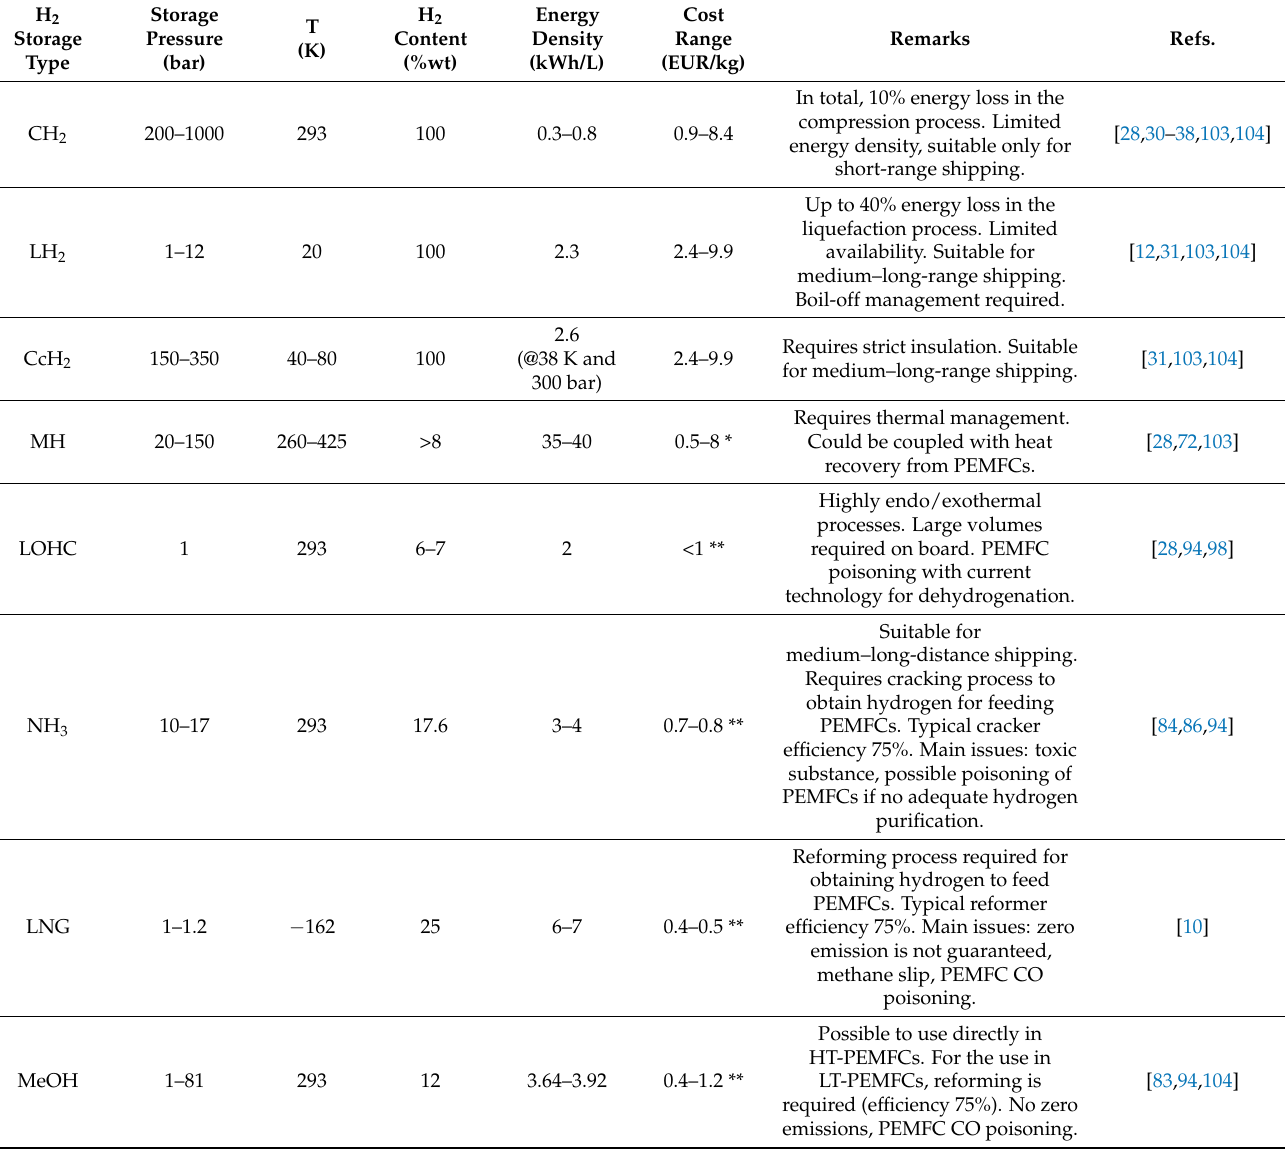
Table 2. Main characteristics of the available hydrogen storage methods. Lower and upper limits of cost ranges for physical hydrogen storage methods and metal hydrides refer to grey and green production methods, respectively (i.e., hydrogen produced from methane via steam reforming or from water via electrolysis powered by renewable energy sources) (T =